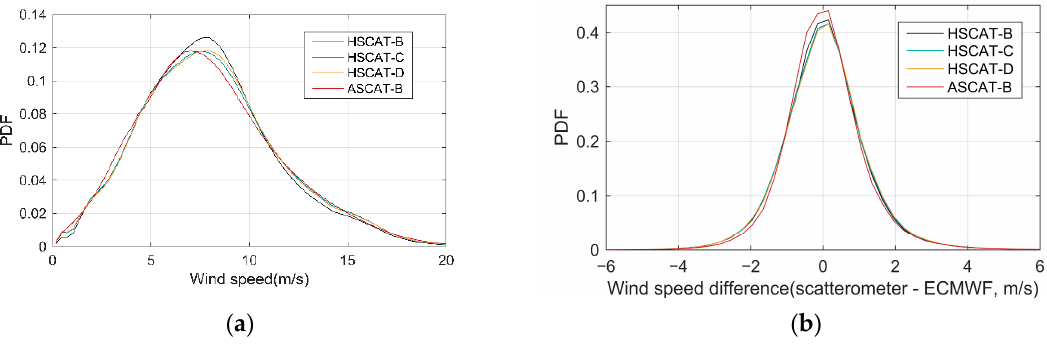
Figure 4. Wind speed probability distribution functions of each scatterometer ( a ) and wind speed deviation PDFs of scatterometers vs. ECMWF data ( b ).